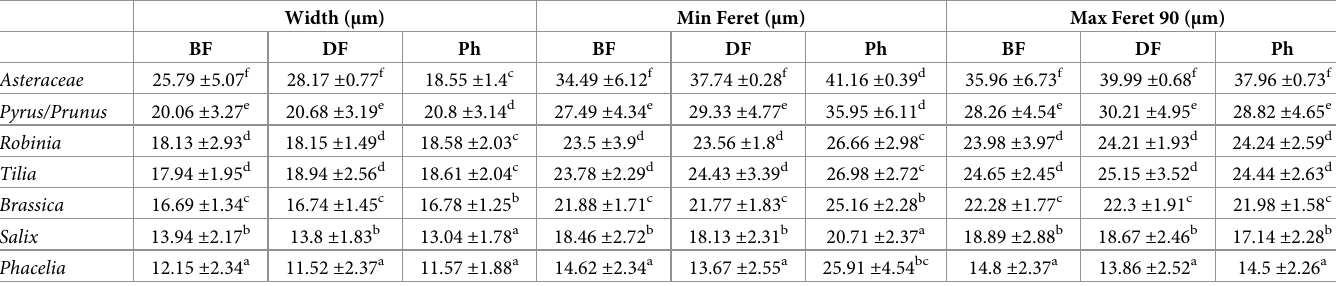
Table 5. Complementary morphological